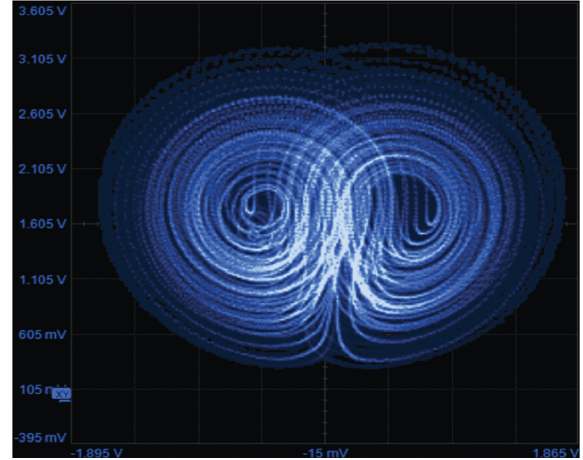
Figure 37: Experimental hyperchaotic attractor of the proposed model (1) in the ( z